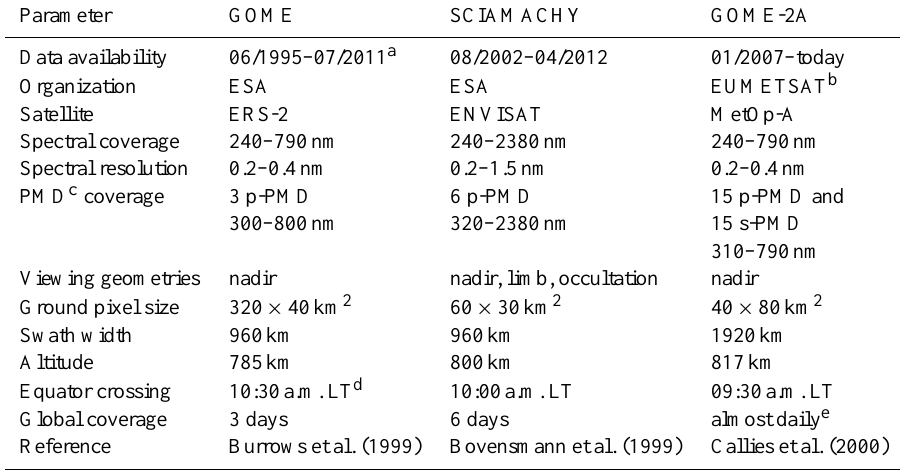
Table 1. European total ozone satellite instrument